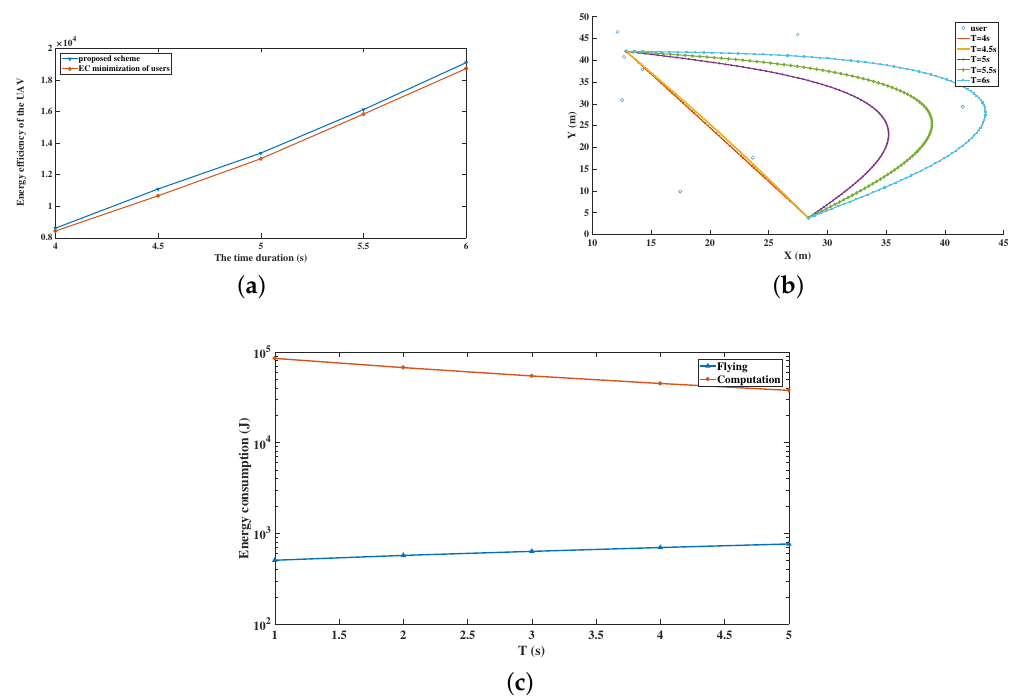
Figure 6. The performance of the UAV under different time constraints. ( a ) Energy efficiency of the UAV with different time constraints; ( b ) Trajectory of the UAV with different time constraints under the proposed scheme; ( c ) Energy consumption of the UAV with different time constraints under the proposed